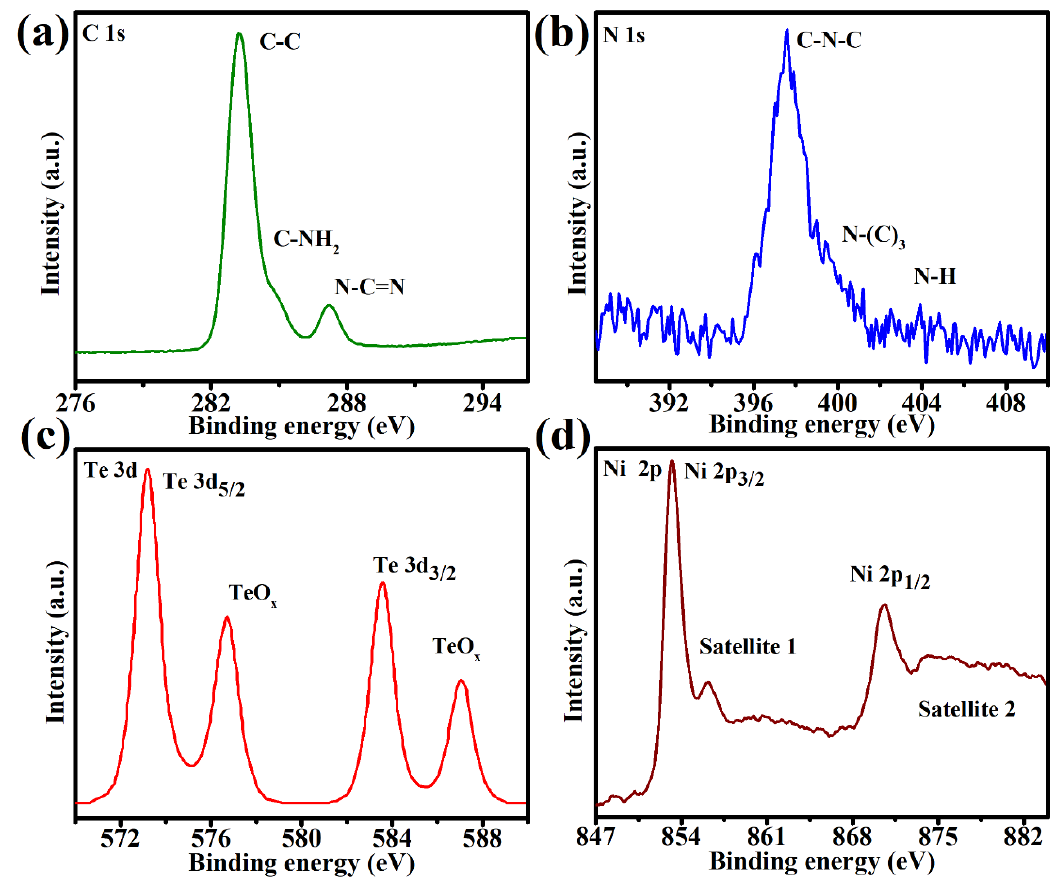
Figure 6. High-resolution XPS spectra of 70%SGCN/1%Te@NiS NCs: ( a ) C 1s, ( b ) N 1s, ( c ) Te 3d, and ( d ) Ni 2p.